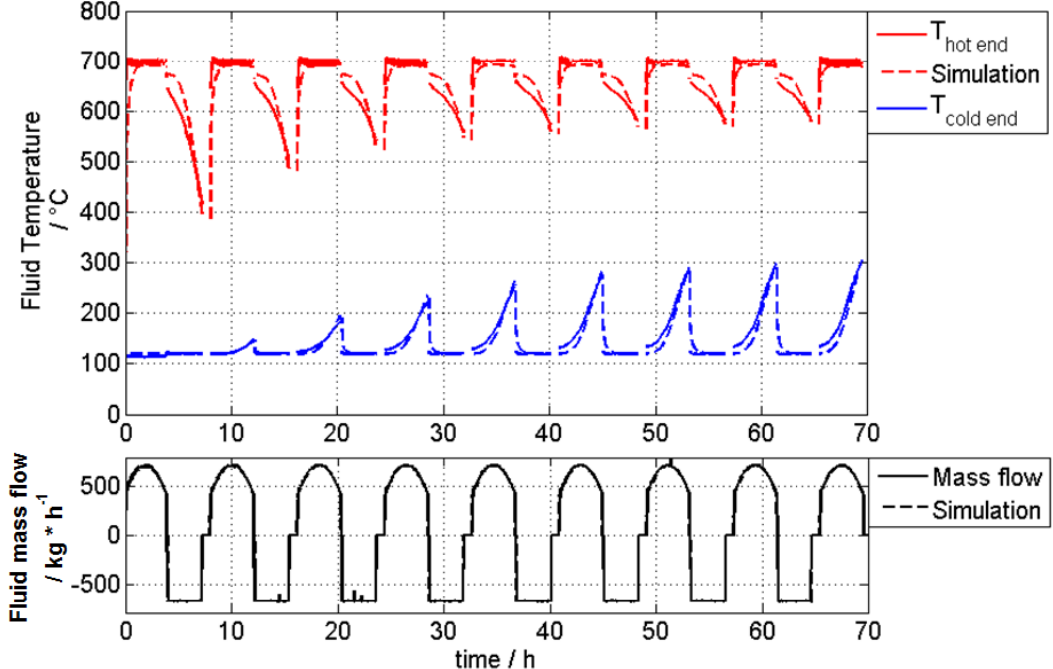
Figure 9. 21 December: Fluid temperature at TES cold end (blue) and hot end (red), mass flow while charging and discharging (black); solid lines represent the experimental results and dashed lines show the simulation model results. Appl. Sci. 2020, 10, 931